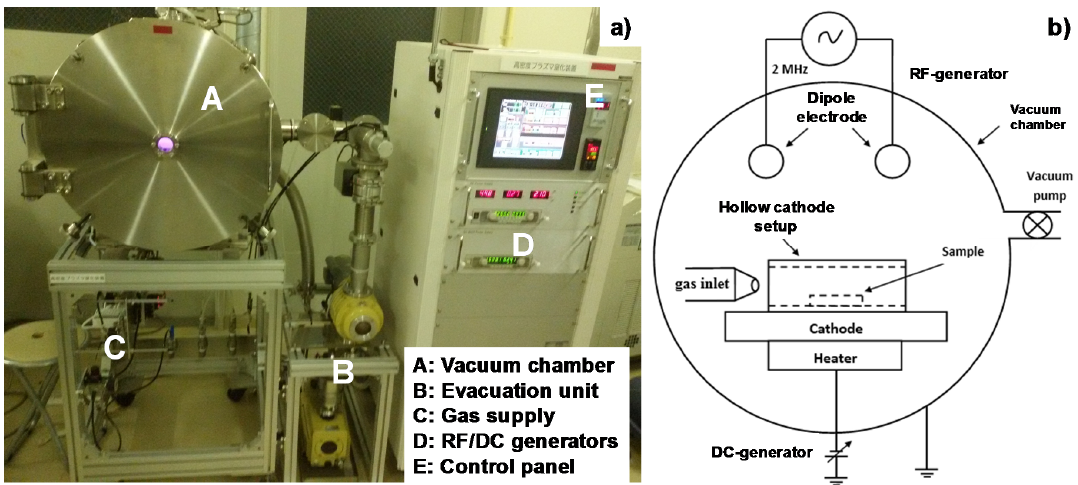
Figure 1. High density radio-frequency–direct-current (RF–DC) plasma nitriding system with use of the hollow cathode device; a ) the whole system; b ) illustration of experimental setup.